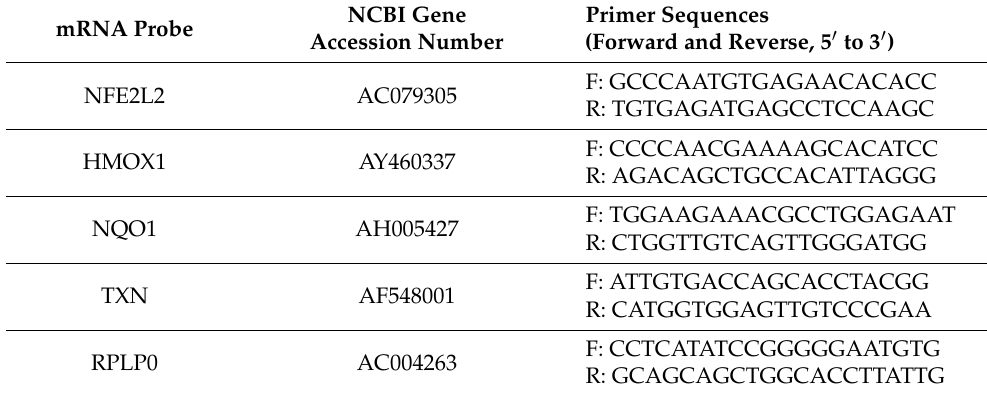
Table 1. The output values were normalized to RPLP0 expression. Table 1. Primer sequences utilized for